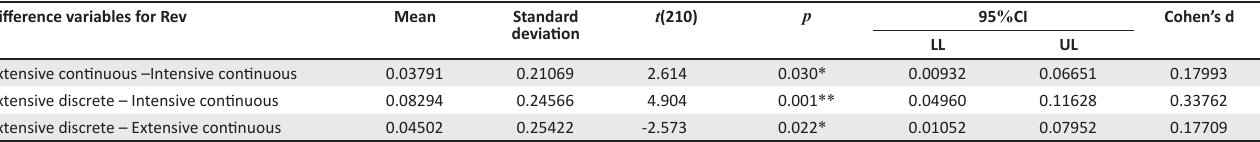
TABLE 5: Differences depending on the type of magnitude for the variable Rev in the Spanish context. Difference variables for Rev